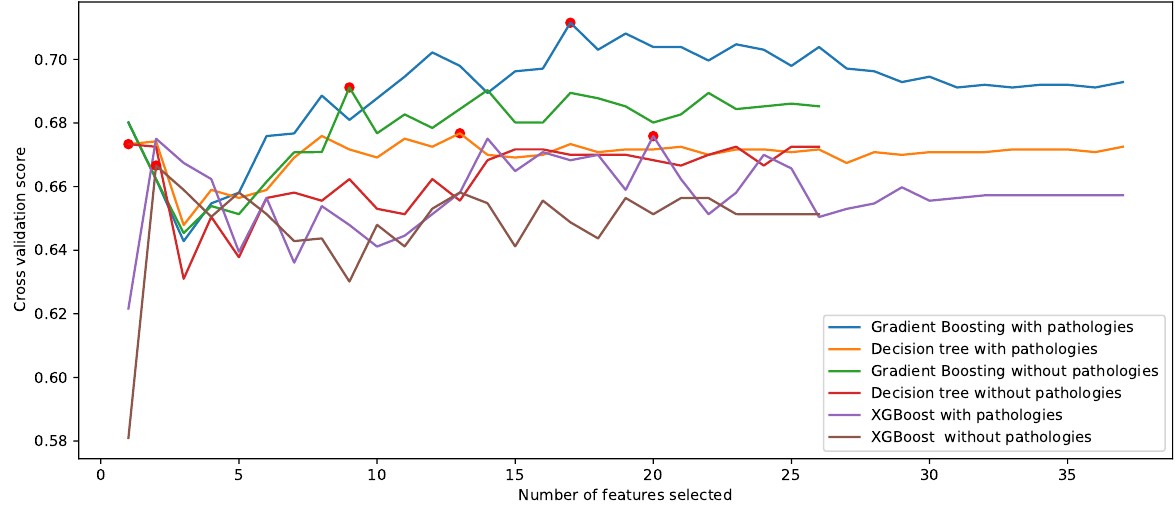
Figure 3. Mean accuracy evolution graph with